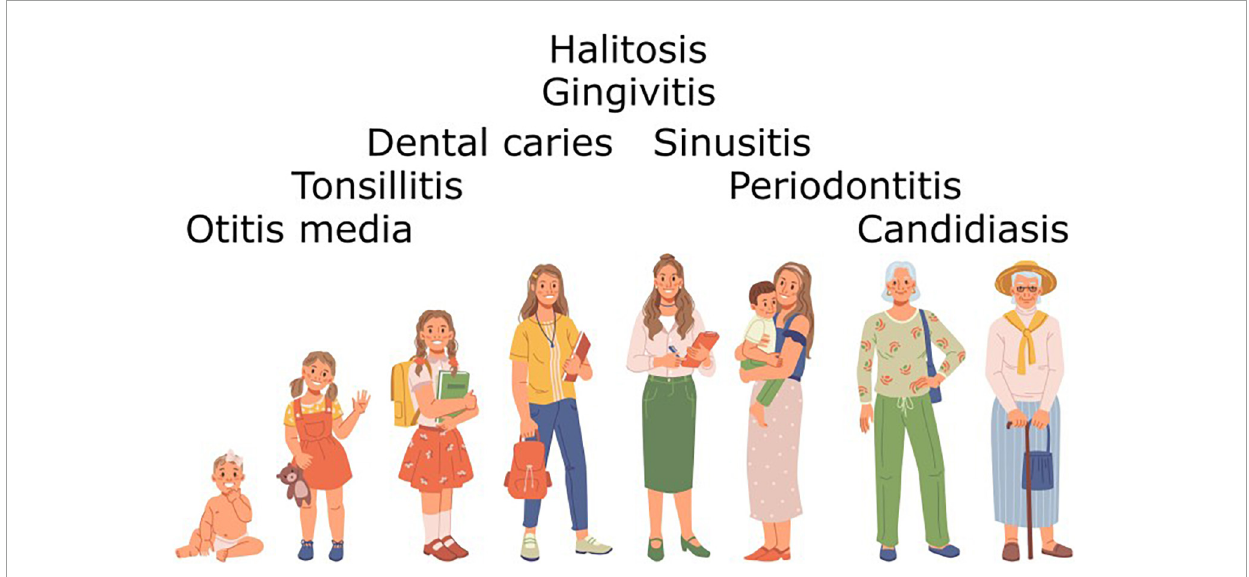
FIGURE6 Diseases presenting at different stages of the life of the human host that have already been shown to be beneficially modulated by administration of BLIS-producing S. salivarius